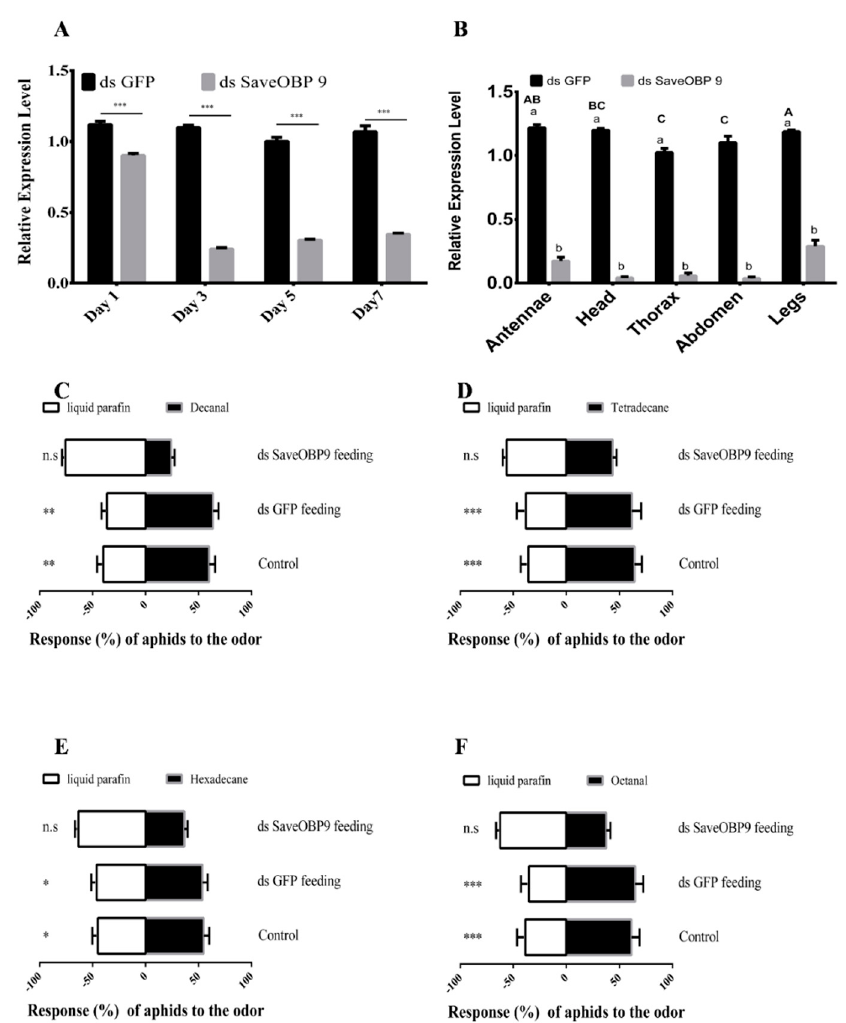
Figure 5. Dietary RNA interference of SaveOBP9 and change in expression level after gene silencing. ( A ) Analysis of mRNA transcript levels of SaveOBP9 after dsSaveOBP9 feeding for 1, 3, 5, and 7 days. ( B ) Analysis of mRNA transcript levels in di ff erent tissues of SaveOBP9 after dsSaveOBP9 feeding after 3 days. β actin was used as an internal reference gene. The results were evaluated using a 2 −ΔΔ CT method, and the 2 −ΔΔ CT value of calibration equals 1.0. Asterisks on the upper side of the bars identify that the values were significantly di ff erent (*** p ≤ 0.001, ** p ≤ 0.01, and * p ≤